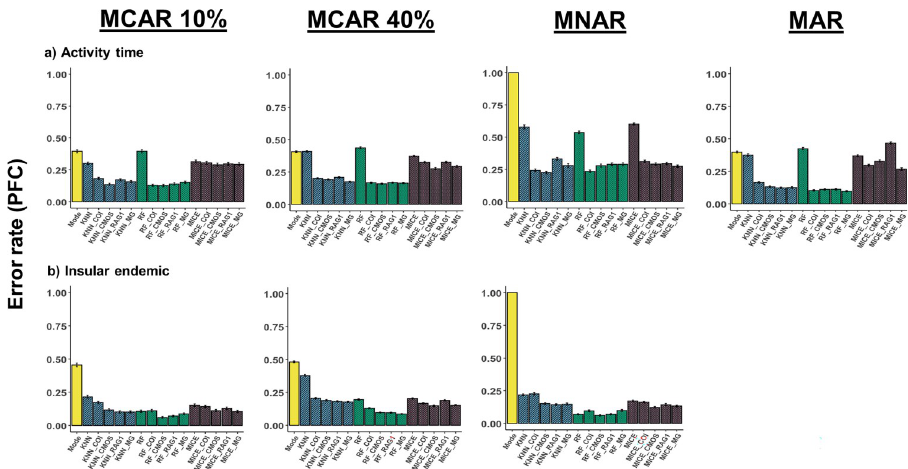
Fig 3. Imputation performance under different missingness mechanisms for categorical traits. Comparison of error rates (PFC) for the methods mean/mode imputation, KNN , RF , and MICE under different missingness mechanisms with and without the addition of phylogenetic information. Phylogenetic information was added in the form of trees built from sequence data of mitochondrial cytochrome c oxidase subunit I (COI), nuclear oocyte maturation factor (c-mos), recombination activating gene 1 (RAG1), and a composite multigene (MG) tree. Performances were quantified using PFC for the categorical traits a) activity time and b) insular endemic. PFC values for each trait were averaged across 100 dataset replicates. MAR = missing at random; MNAR = missing not at random.